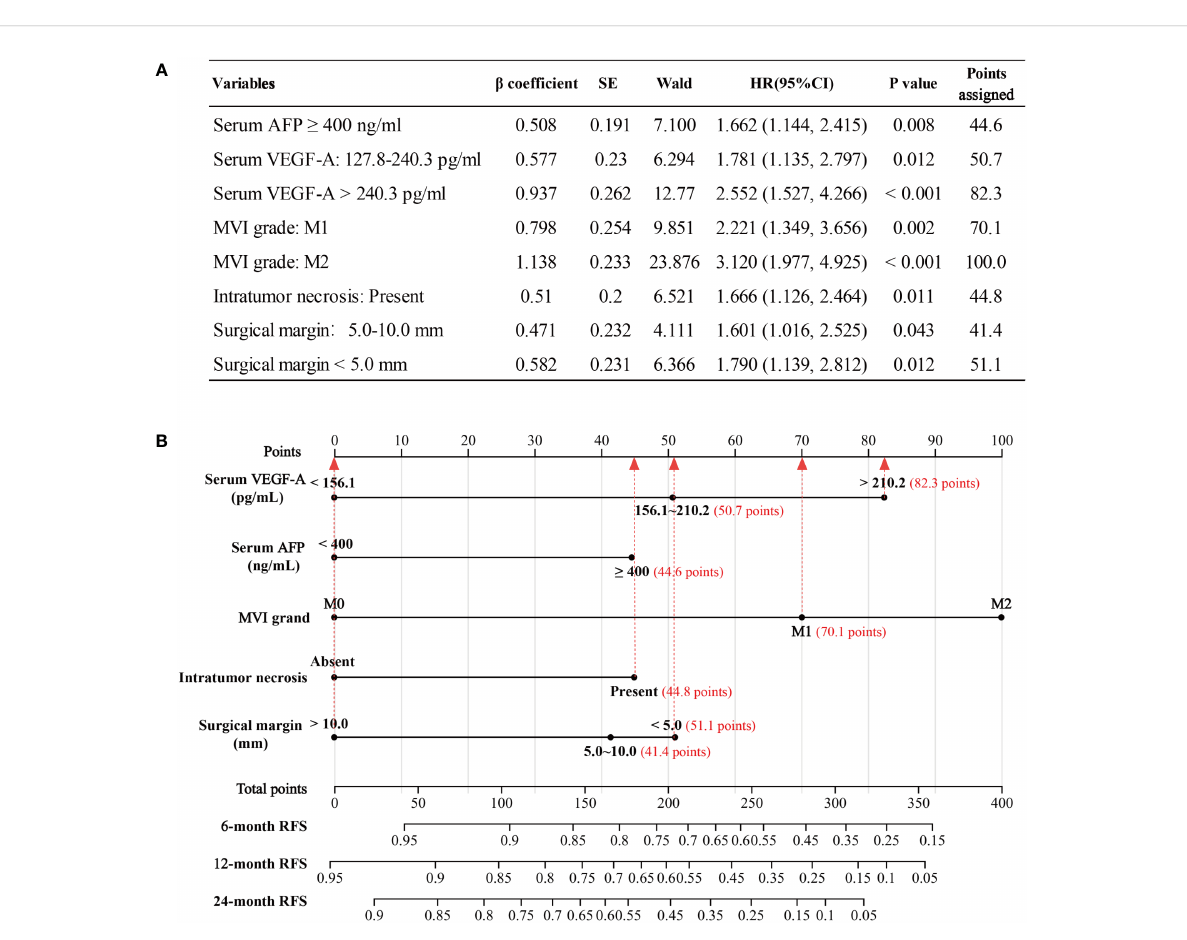
FIGURE 5 Development of the nomogram model. (A) The points assignments of variables based on Cox regression analysis. (B) Nomogram model depicting 6 − , 12 − and 24 − month RFS. The use of nomogram was as follows: Points are assigned for each variable by drawing a straight line upward from the corresponding value to the “ Points ” line. Then, sum the points received for each variable, and locate the number on the “ Total Points ” axis. The 6 − , 12 − and 24 − month RFS can be calculated by connecting each point to the survival line. AFP, alpha fetoprotein; VEGF-A, Vascular endothelial growth factor A; MVI, microvascular invasion, RFS, recurrence − free